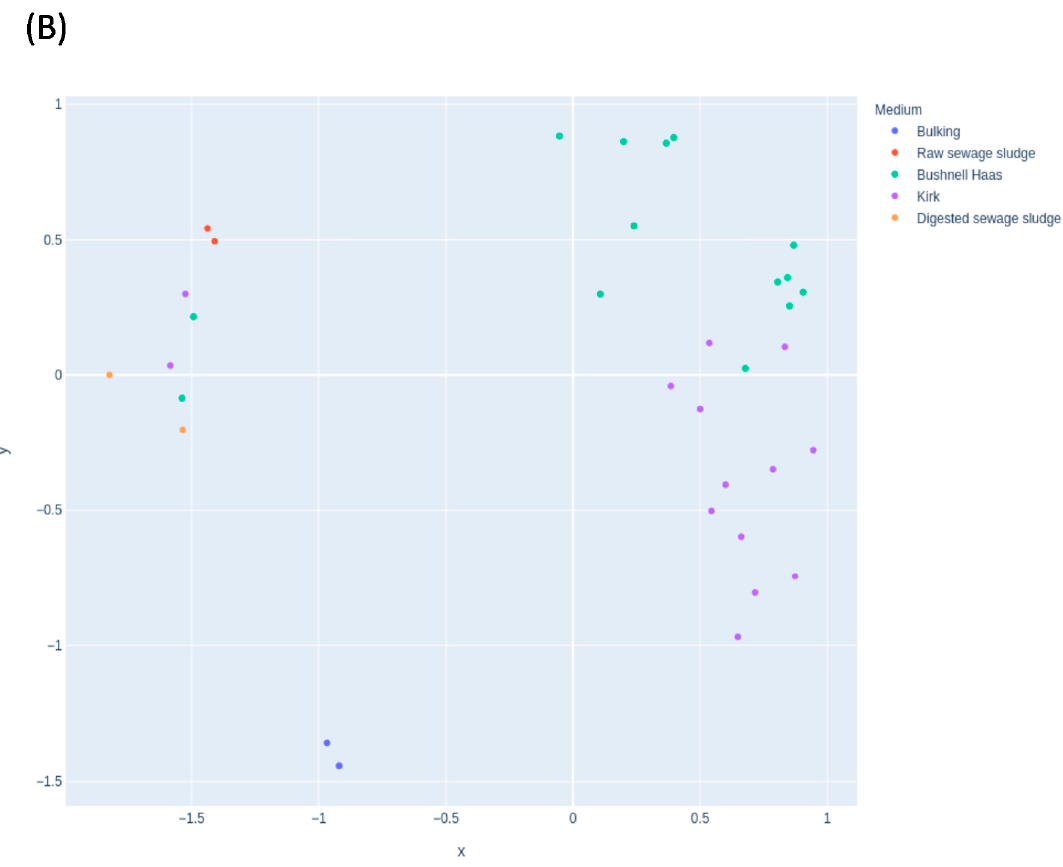
Figure 3. Multidimensional scaling (MDS) plot showing the distribution of samples in the enrichment experiment according to the medium used for ( A ) fungal and ( B ) bacterial communities .